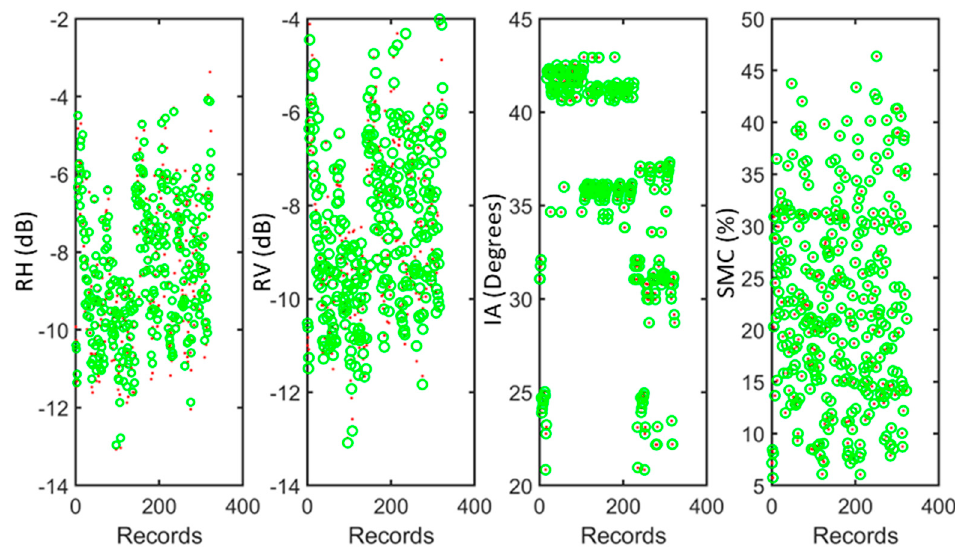
Figure 10. Augmented soil moisture dataset parameters (RH, RV, IA, and SMC). Red dots present the original parameters; Green circles present the autoencoder-derived parameters.